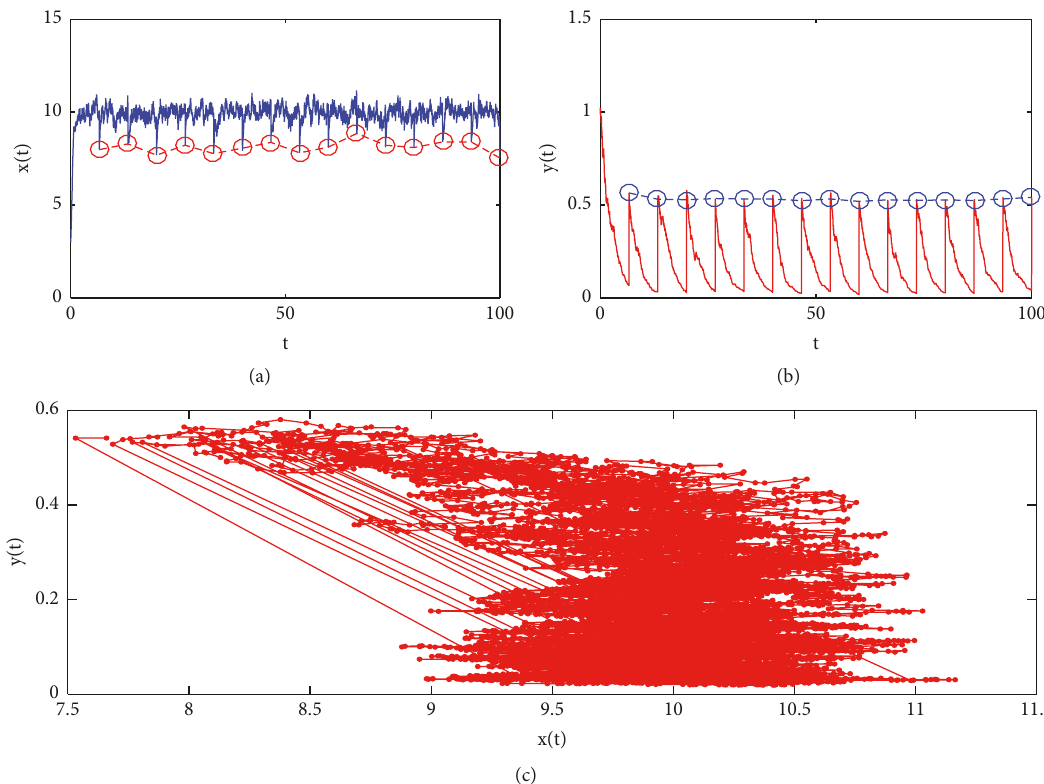
Figure 1: Solutions of model (2) with 𝛼 1 = 0.1,𝛼 2 = 0.15 . The other parameters are fixed as 𝑟 = 2, 𝐾 = 5, 𝑎 = 1, 𝐷 = 0.5, 𝜇 = 0.8, 𝜃 = 0.2, 𝜏 = 0.5, 𝑇 = 6.7, (𝑥 ,𝑦 ) = (3,1) 0 0